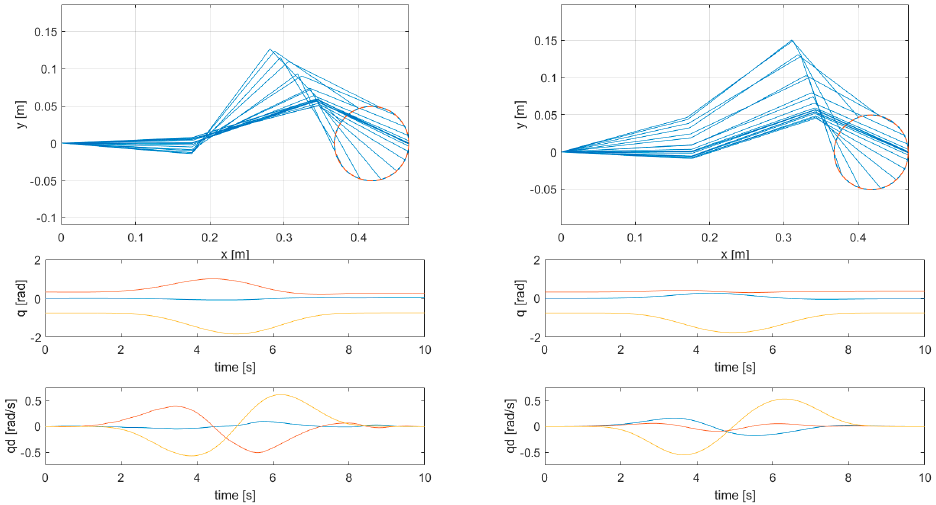
Figure 5. Trajectory 2, comparison between PMKE ( left ) and LSV ( right ). First joint: blue lines; second joint: red lines; third joint: yellow lines.